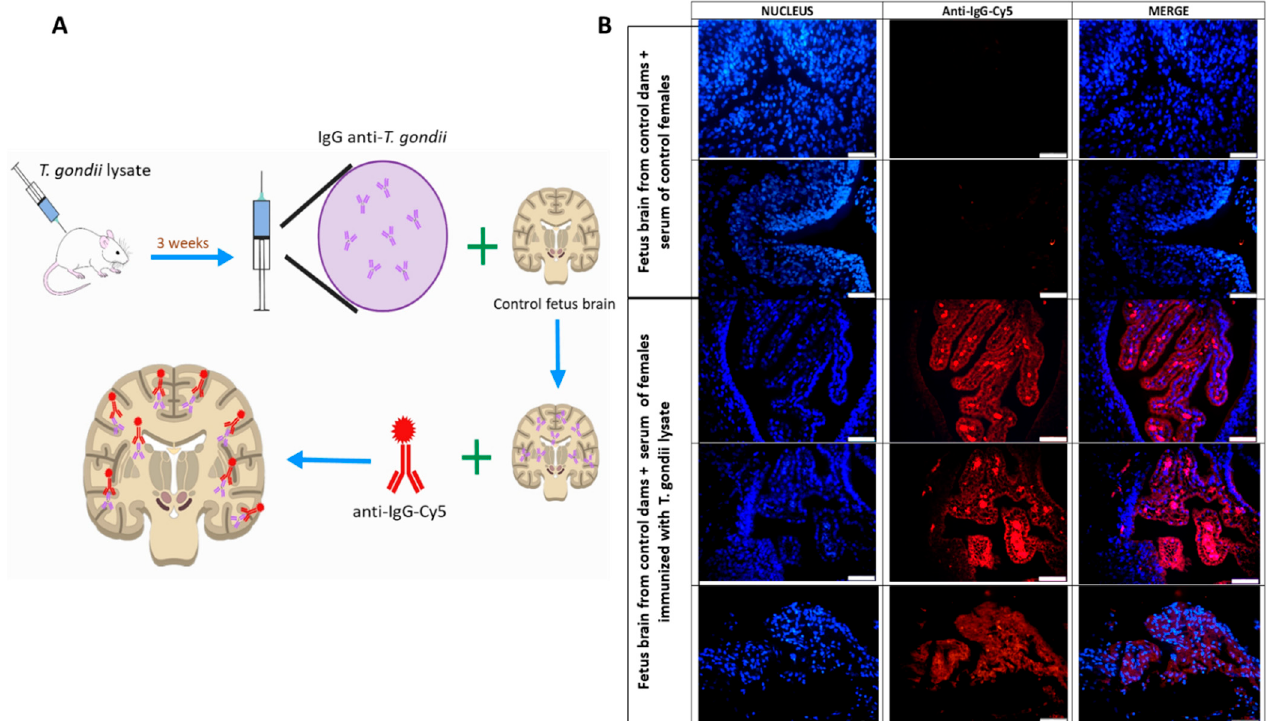
Figure 6. Maternal pathogenic antibodies recognized fetal brain structures. ( A ) Diagram of the experimental design. Rats immunized with the T. gondii lysate or control, received three subcutaneous injections (one per week) with T. gondii lysate or PBS, respectively. Fetus brains at gestational day 18 from the progeny of a non-immunized mother were used to search cross-reactive IgGs. ( B ) Representative images of brain slices of fetuses on gestational day 18 from non-immunized mothers were incubated with serum from females previously immunized with T. gondii . The binding of IgG’s was subsequently evidenced by a secondary anti-rat-IgG-Cy5 (red). Nuclei were counterstained with DAPI (blue). Images were acquired at 40×, the bar represents 100 µm.